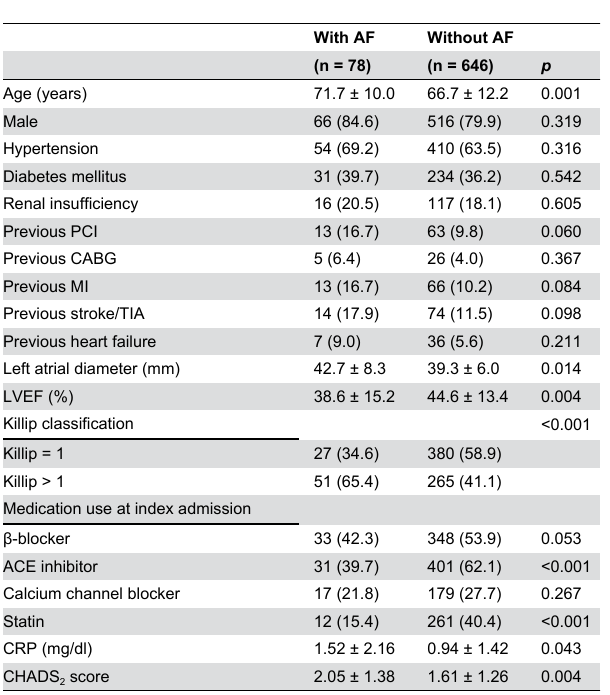
Table 2. Baseline characteristics of patients with and without AF during hospitalization.